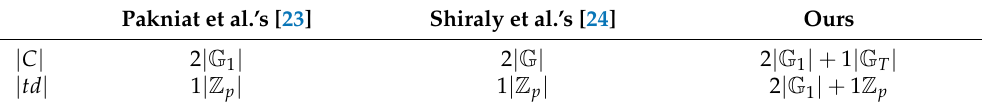
Table 2. Storage overhead comparison.